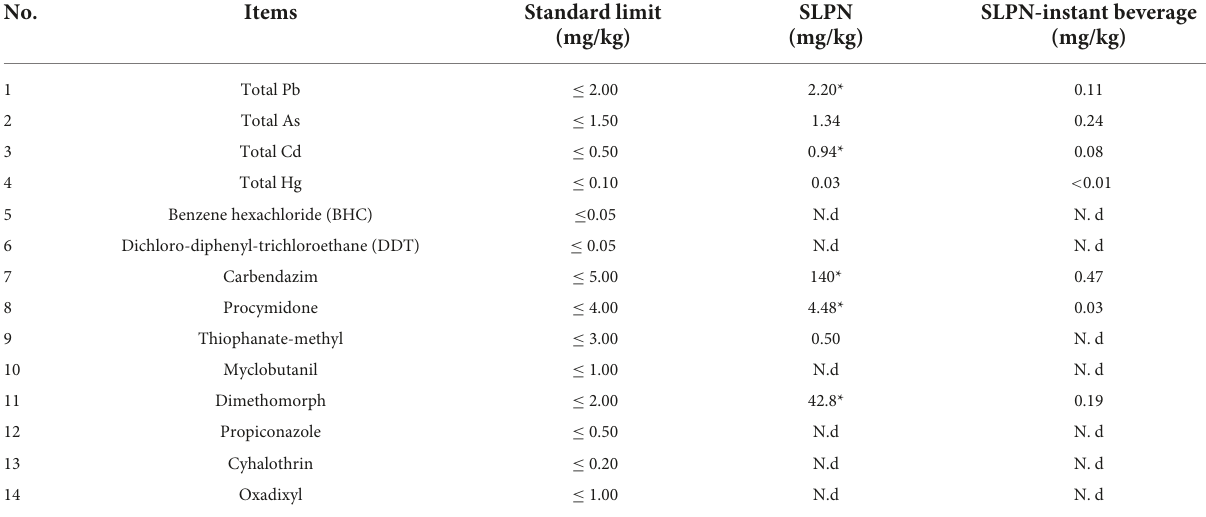
TABLE 3 Pesticide and heavy metal residues in SLPN and SLPN-instant beverage.